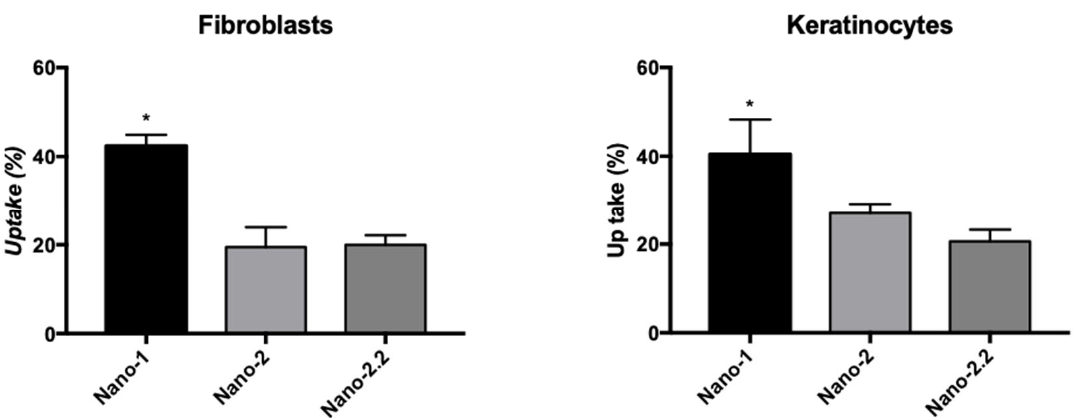
Figure 4. Cellular uptake of Nano ‐ 1 and Nano ‐ 2 compared to Nano ‐ 2.2, with nanoparticle size similar to that of Nano ‐ 1, after 5 min of contact with a monolayer of fibroblasts and keratinocytes. Results were statistically analyzed by ANOVA analysis of variance, followed by Tukey’s test. (*) indicates statistically significant difference with P < 0.05 (n = 3 determinations).